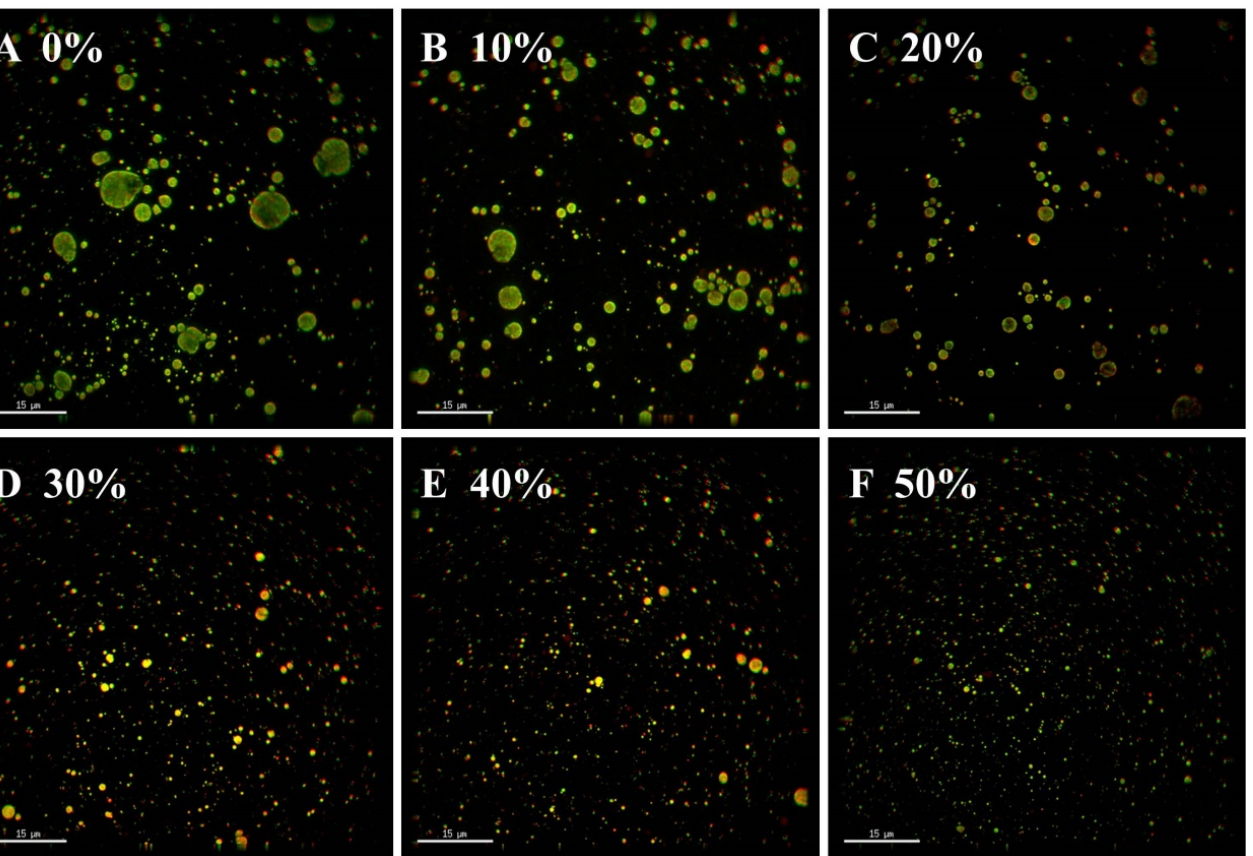
Figure 3. Effects of different SOB substitution amounts on microstructure of ice cream. Figure 3A-3F represent the ice cream with 0%, 10%, 20%, 30%,40% and 50% of SOB substitution for milk fat, respectively.